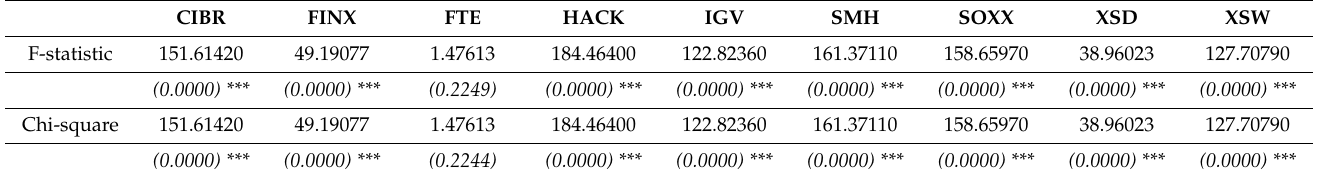
Table A7. WALD Test for the idiosyncratic risk coefficient.